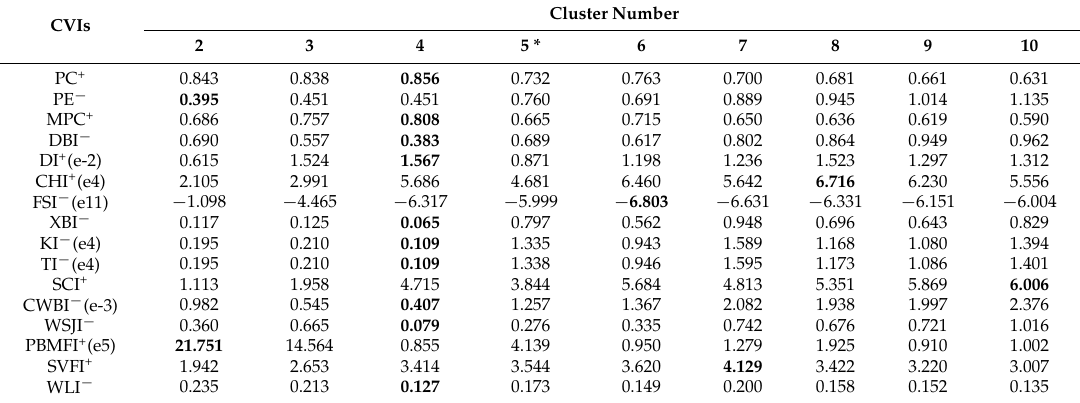
Table 11. Variations of the 16 CVIs with cluster numbers ranging from 2 to 10 for the AVIRIS image.